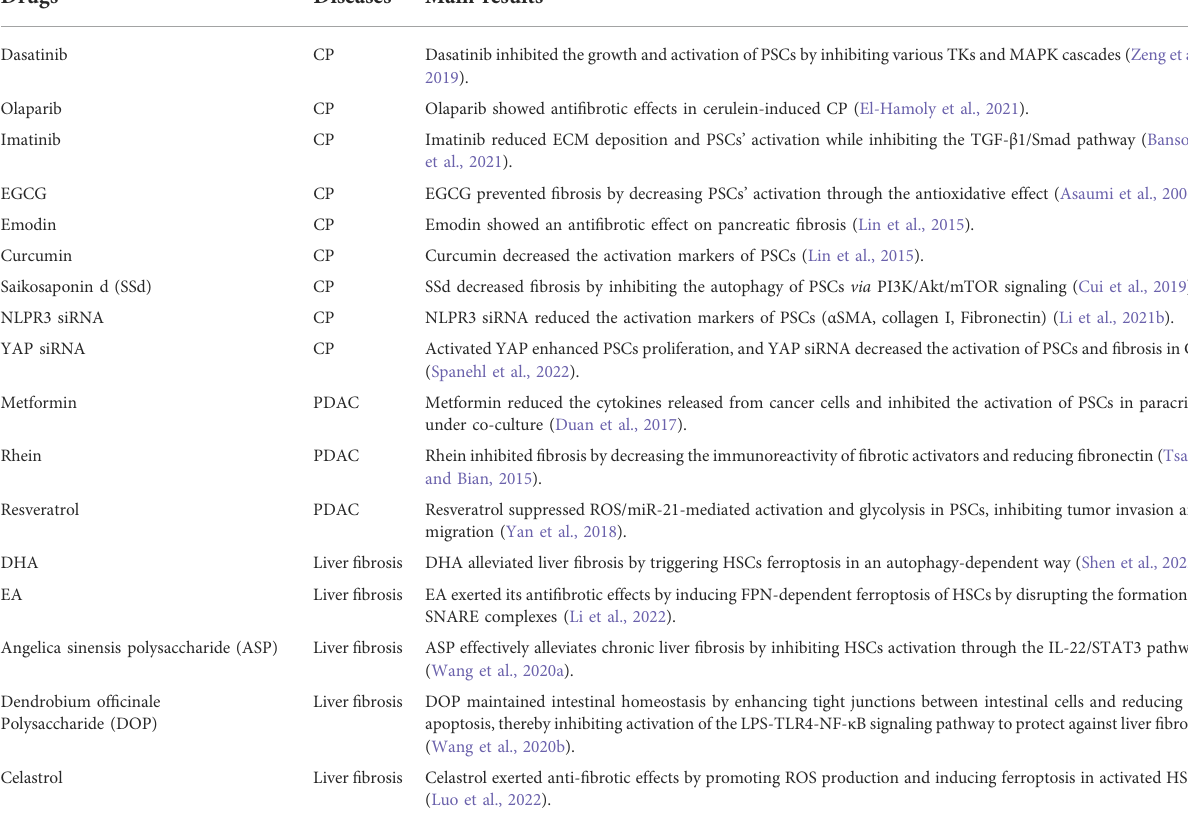
TABLE 1 Potential anti fi brotic drugs in the treatment of CP. Drugs